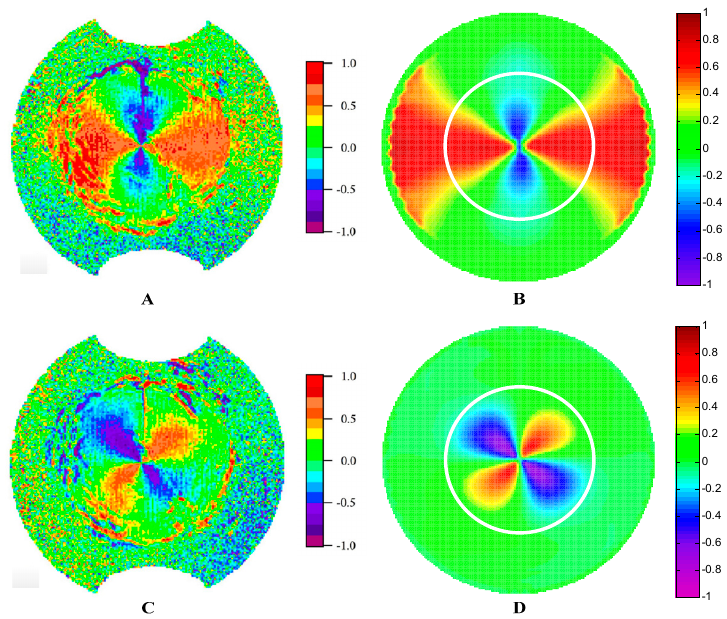
Figure 15. Q / I ( A ); and U / I ( B ) graphs measured by Bhandari [24]. Simulated: Q / I ( C ); and U / I ( D ) graphs.